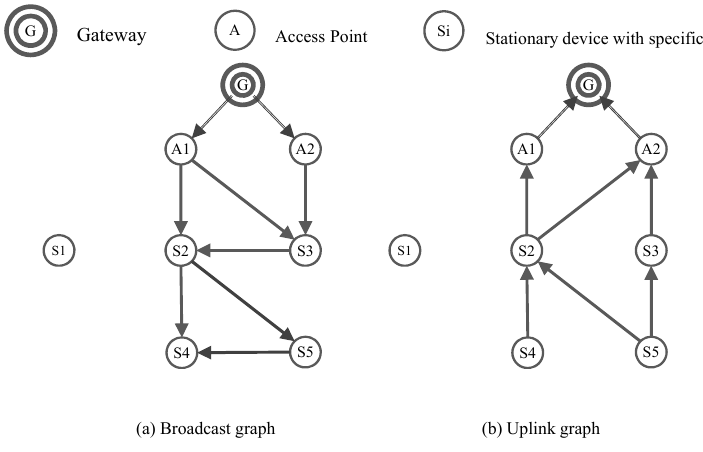
Figure 3. An example of skeleton graph construction by